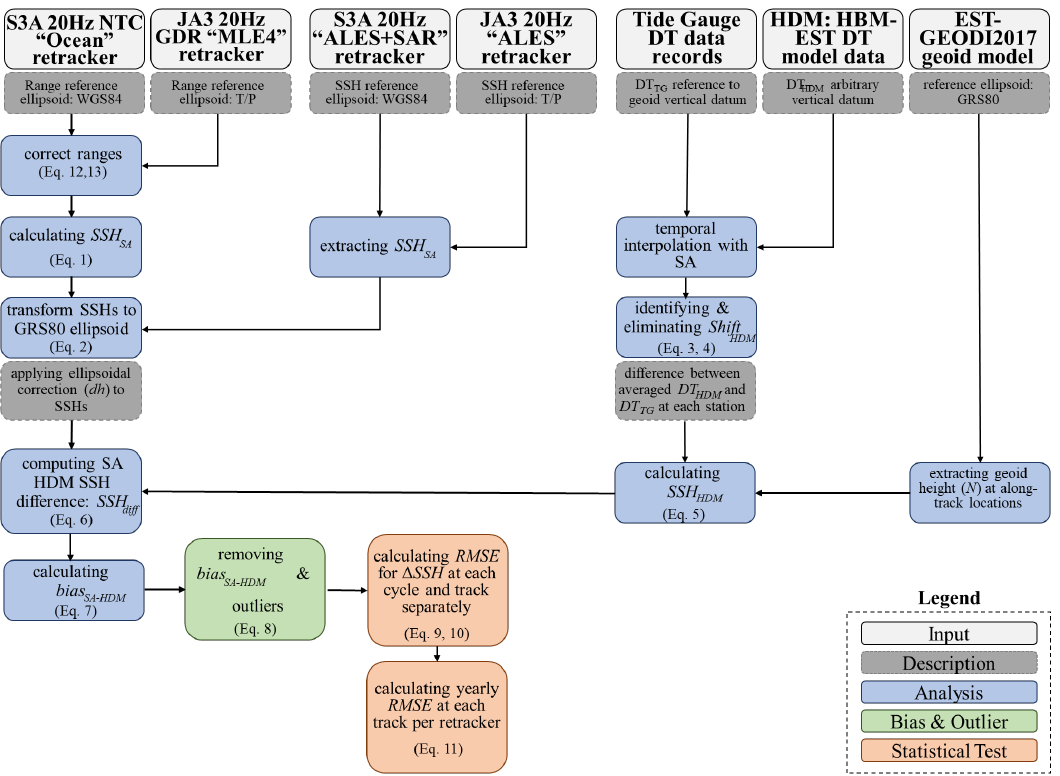
Figure 3: Flowchart of different stages of the developed method for validating the satellite altimetry retracker.